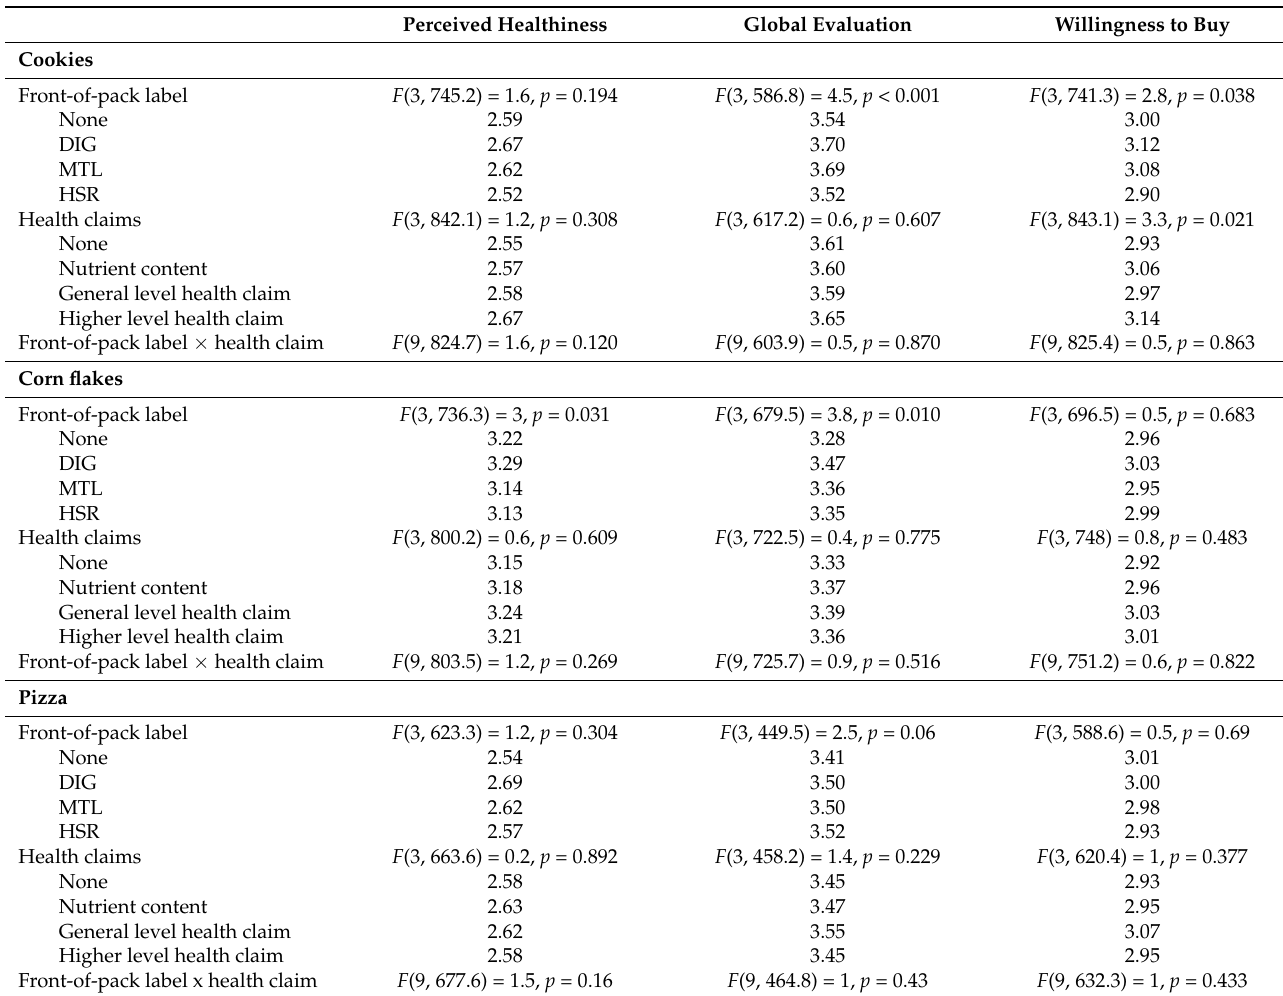
Table 3. Means, main effects and interaction effects for front-of-pack labels and health claims (with age, gender and Socio-Economic Status as covariates) on perceived healthiness, global evaluations and willingness to buy according to food type ( n =